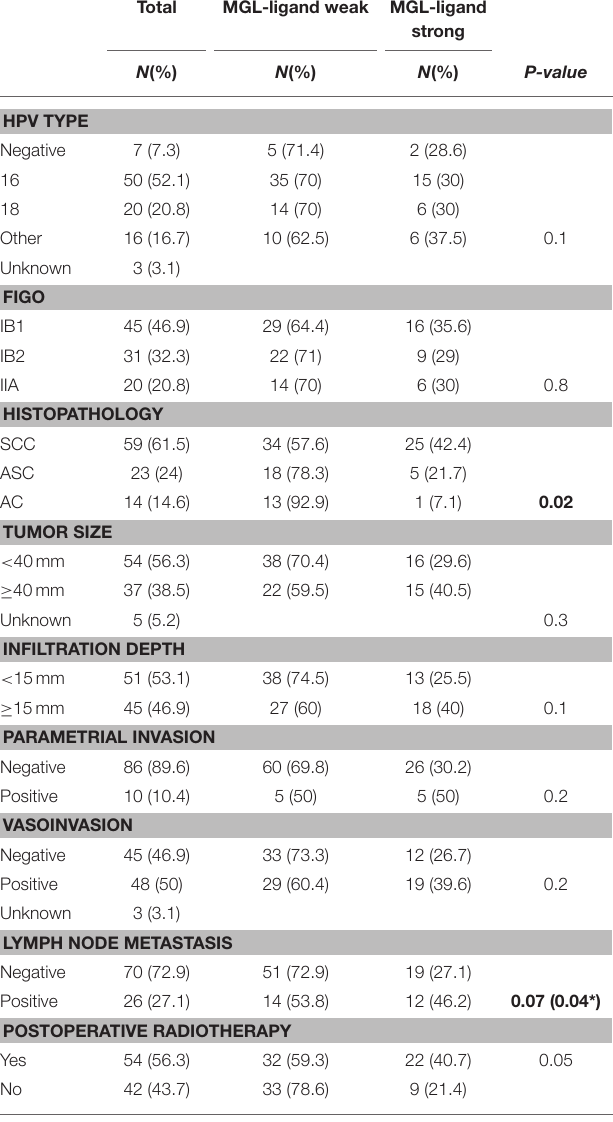
TABLE 1 | Clinicopathologic characteristics of the studied cohort ( n = 96) in relation to MGL-ligand